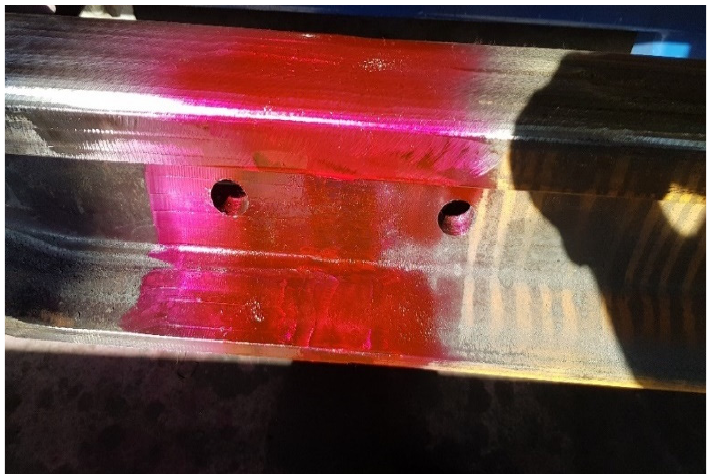
Figure 9. The penetrant penetration process. Source: own.